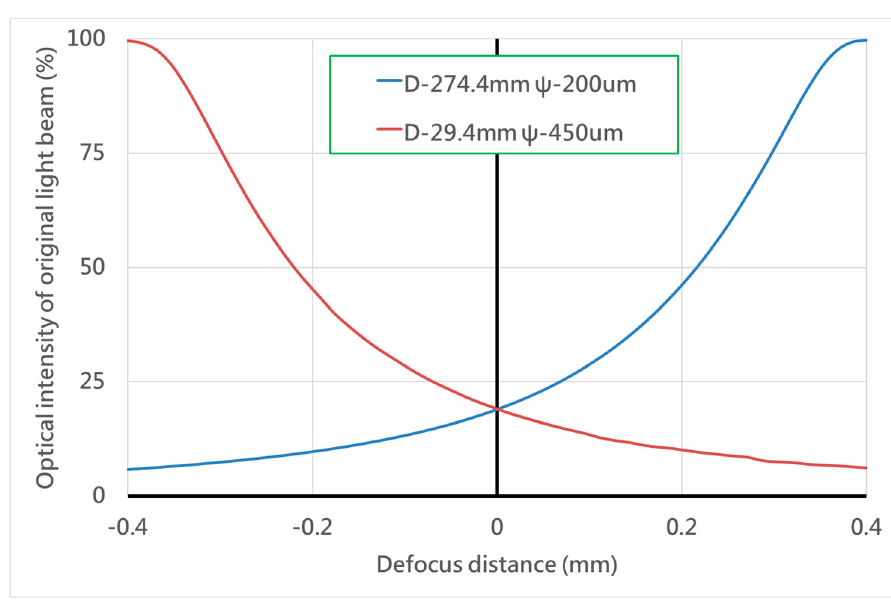
Figure 5. Simulation of the intensity signals from the two photodetectors.